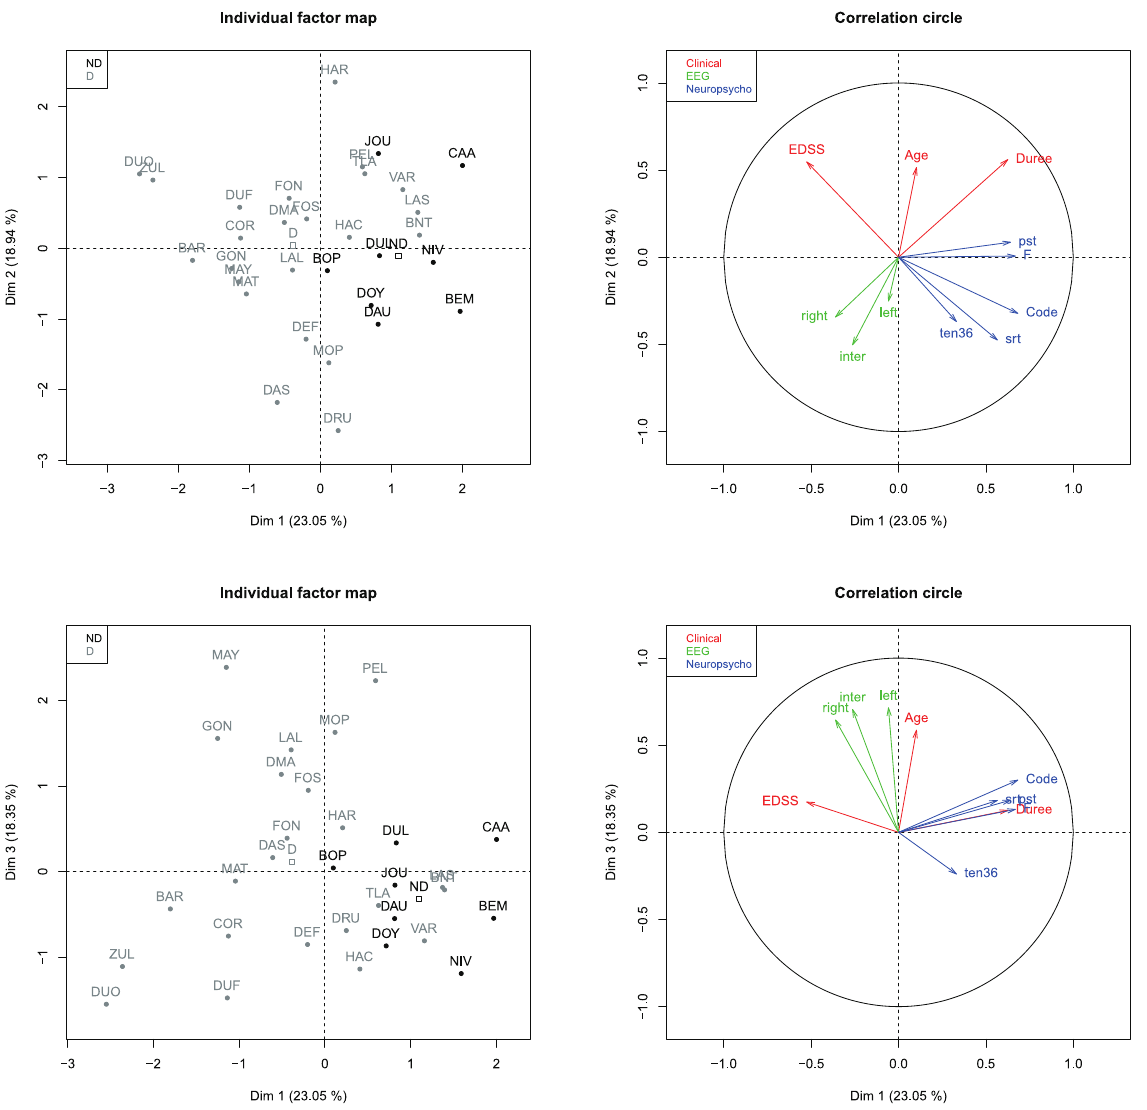
Fig. 4. Distribution of the individuals (left column) and correlation circles (right column) in planes: dim. 1 × dim. 2 ( fi rst line) and dim. 1 × dim. 3 (second line) after multiple factor analysis. On the left, the patient with cognitive de fi ciency (D) are shown in gray and those without cognitive de fi ciency (ND) are depicted in black. On the right, the clinical variables (age, duration of the illness and EDSS), the electrophysiological ones (EEG for inter-hemispheric, right and left averaged mutual information) and the neuropsychological variables (pst: paced auditory serial addition test, F: fl uency test, code: code subtest, ten36: 10/36 visuo-spatial learning test and srt: selective reminding test) are shown in the correlation circle (resp. red, green and blue, in the online fi le: